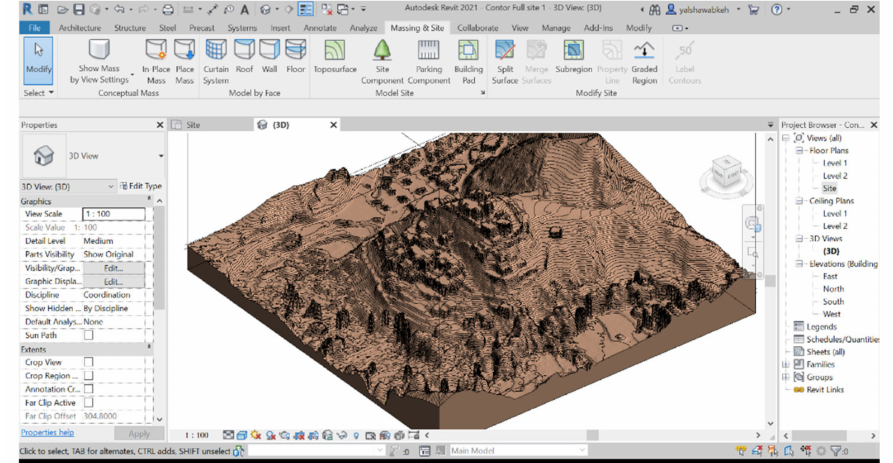
Figure 18. Result of BIM terrain and landscape